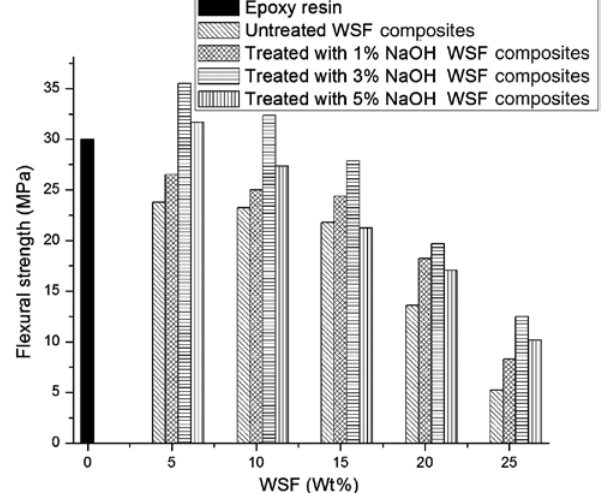
Figure 1: Effect of fiber content and alkali treatment on the tensile strength of WSF-epoxy